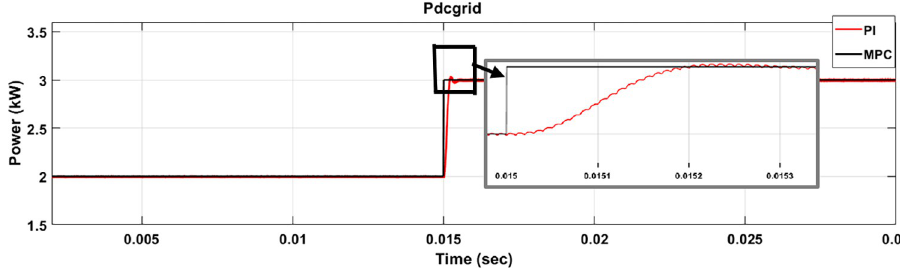
Fig 20. DC bus voltage regulation using PI and